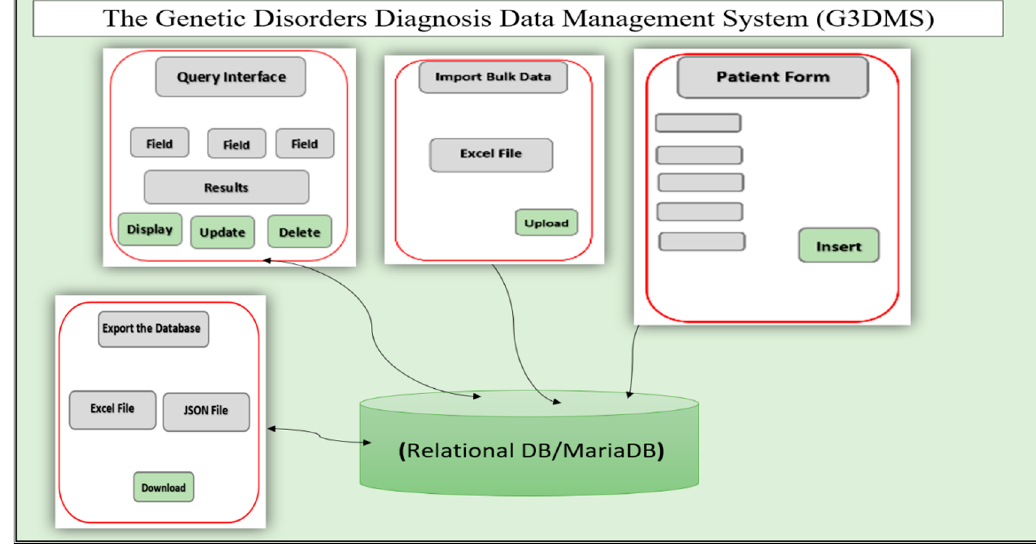
Figure 1. The Genetic Disorders Diagnosis Data Management System (G3DMS) architecture.